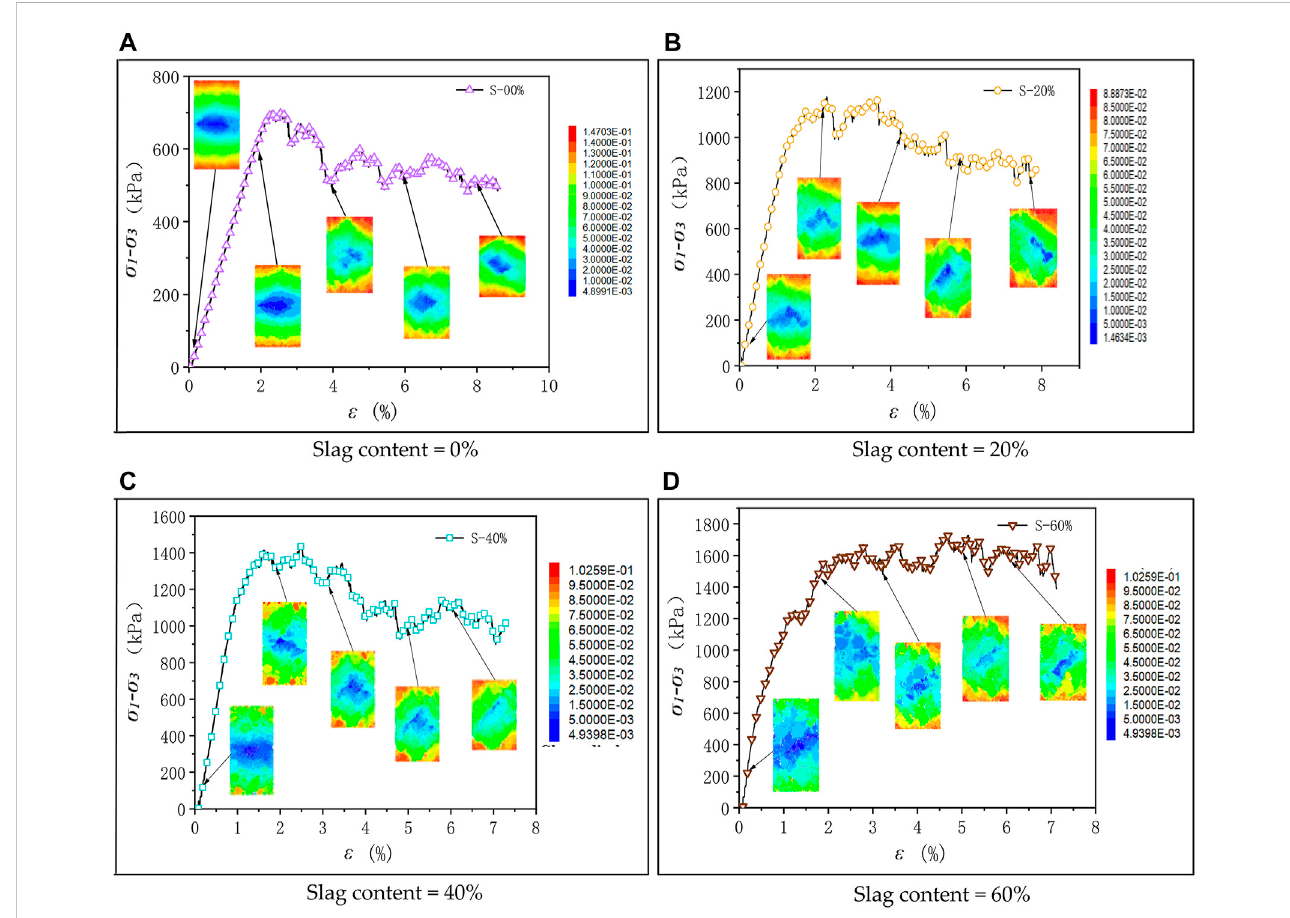
FIGURE 10 Displacementcontourplotsat fi vestagesalongthedeviatorstress-straincurvesofthefourTSMspecimenswith (A) slagcontent=0%, (B) slagcontent= 20%, (C) slag content = 40%, and (D) slag content = 60% when the con fi ning pressure of 300